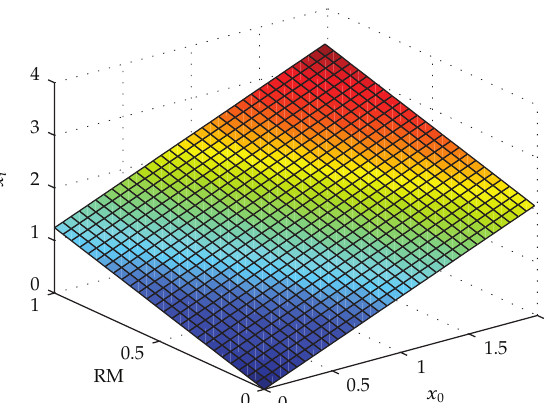
Figure 1: The relationship among ξ , x 0 and RM.